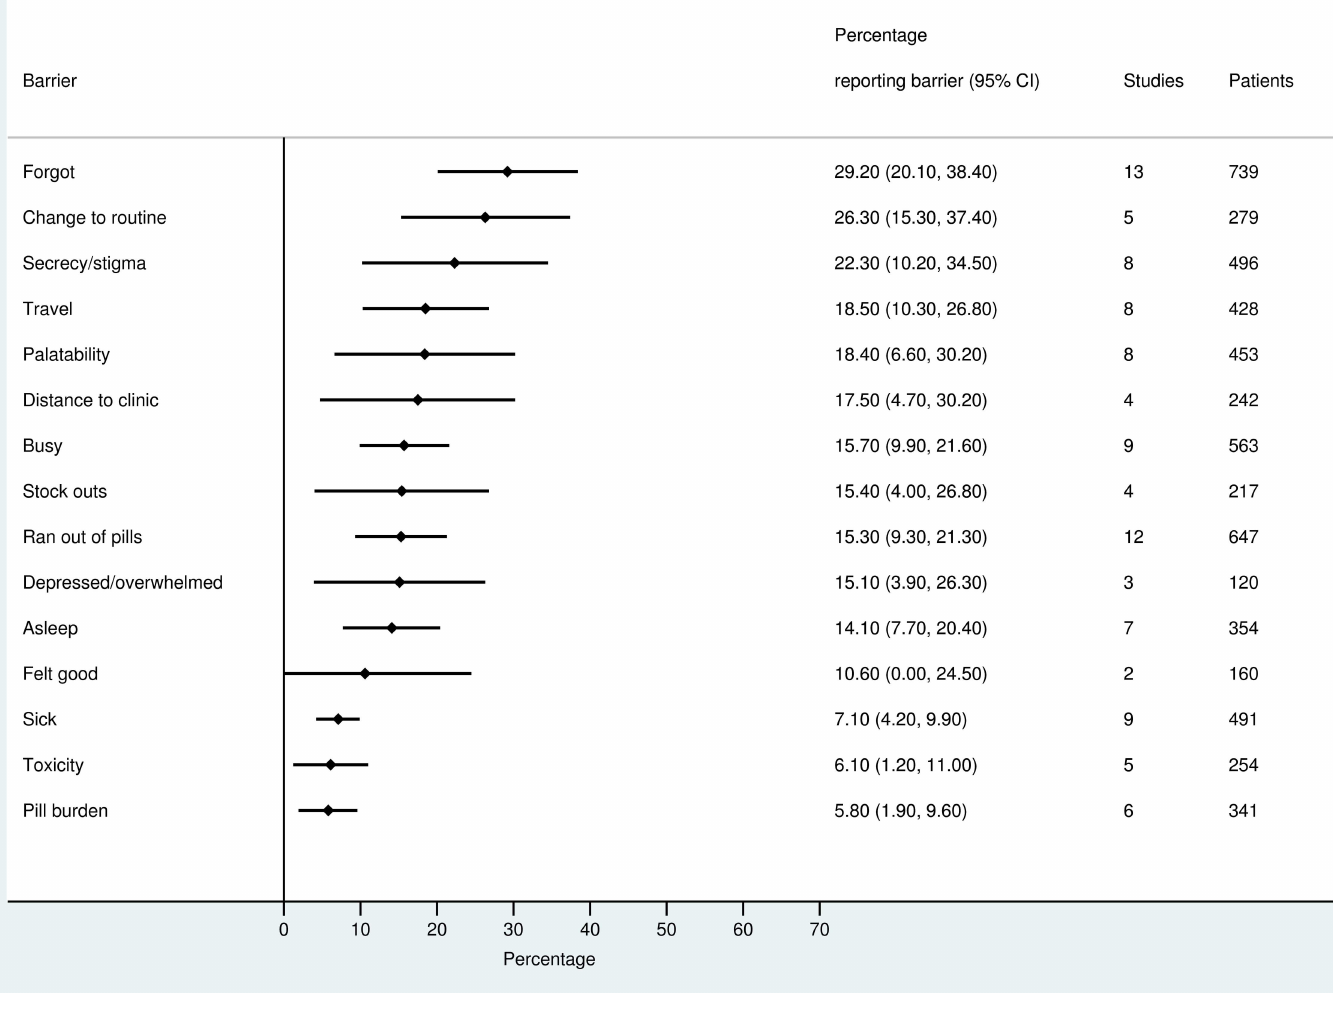
Fig 3. Barriersto adherence among children on